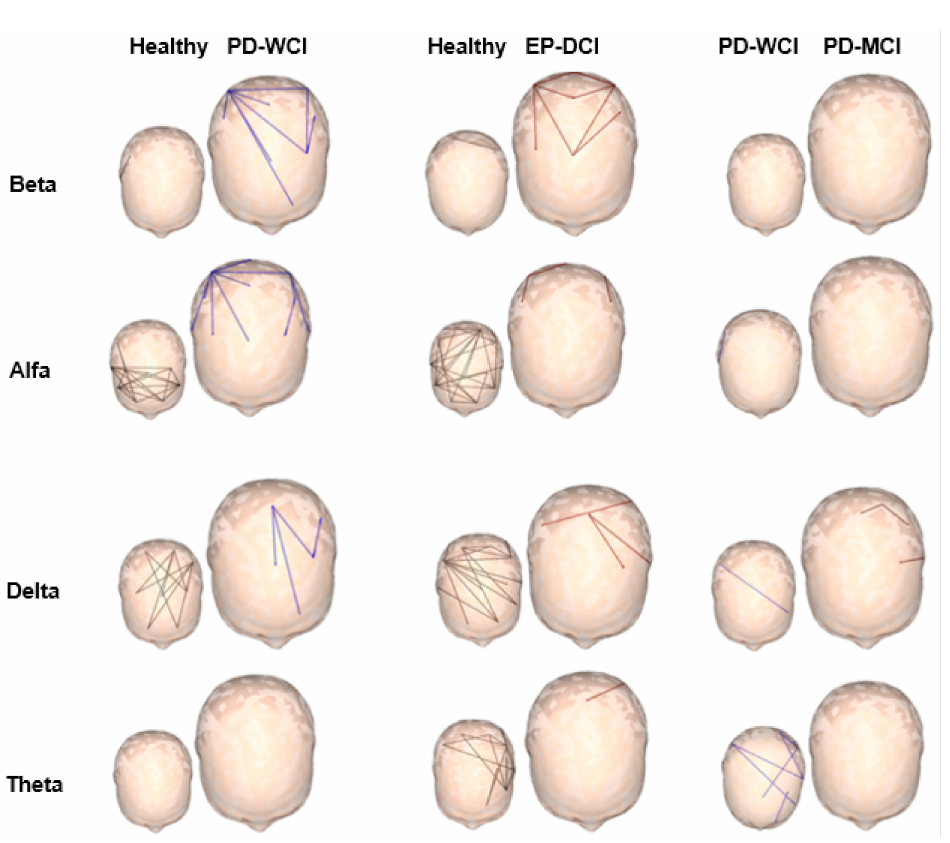
Figure 1. Significant connections between electrode pairs for each EEG frequency (alpha, beta, theta, and delta). The different colors represent the significance values p < 0.05 of the permutations test used for each of the groups studied: healthy subjects in black, patients without cognitive impairment (PD-WCI) in blue, and patients with mild cognitive impairment (PD-MCI) in red. In the skull-shaped figures, the largest size does not represent statistical differences, it is used to highlight the result of the group of greatest interest according to the objectives of the